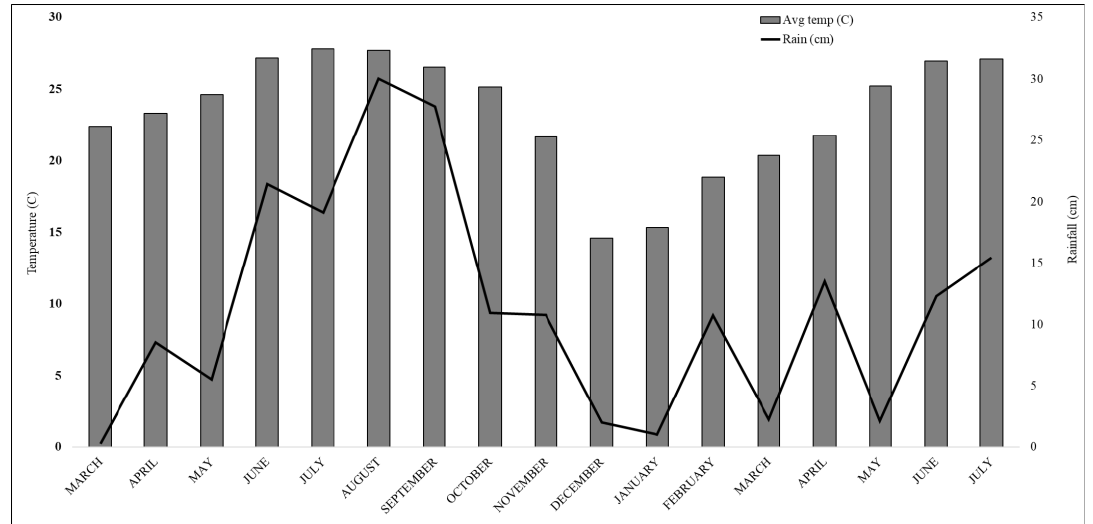
Figure 1. Average monthly temperature (C) and cumulative rainfall (cm) over both experimental runs (March 2020 to July 2021). Plants growing in 3.8 L and 11.4 L containers were harvested at 48 weeks after potting (WAP), while plants growing in 24.7 L and 56.8 L containers were harvested at 60 WAP. From January to March 2021, creeping woodsorrel ( Oxalis corniculata L.) and Pennsylvania sedge ( Carex pensylvanica Lam.) were observed in most containers resulting from natural inoculation. Beginning in late March to April 2021, the same warm season annual weed species were noted, still dominated by Bidens alba but also included dense populations of spotted spurge ( Euphorbia maculata L.) from natural inoculation. Throughout the remainder of the experiment, the dominant species in the containers included Bidens alba , Eclipta prostrata , Euphorbia maculata , Euphorbia hirta , and Phyllanthus tenellus